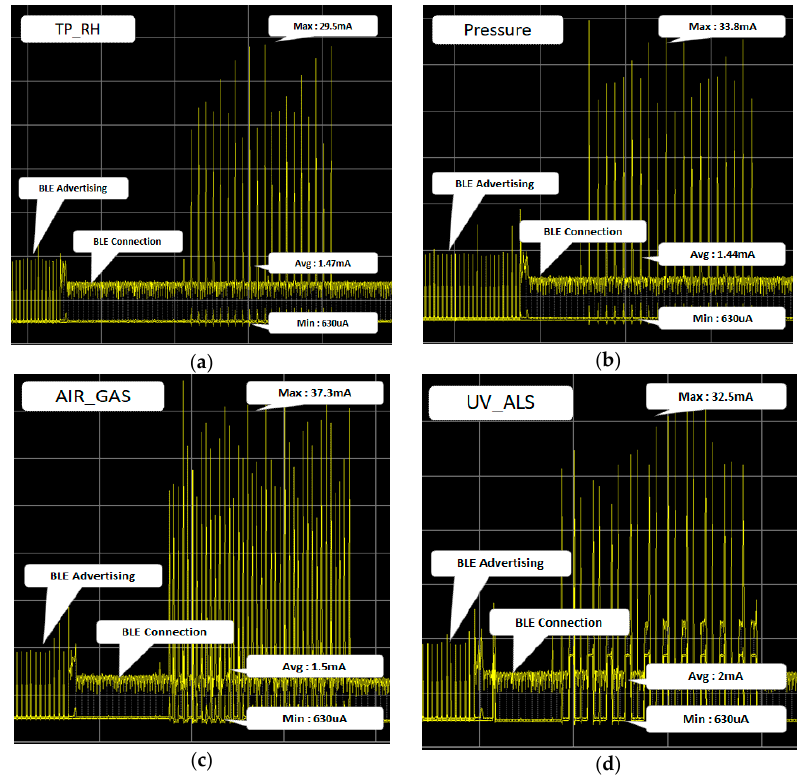
Figure 13. Power status when reading sensors: ( a ) temperature and humidity sensor; ( b ) air pressure sensor; ( c ) atmosphere sensor; ( d ) ultraviolet sensor.